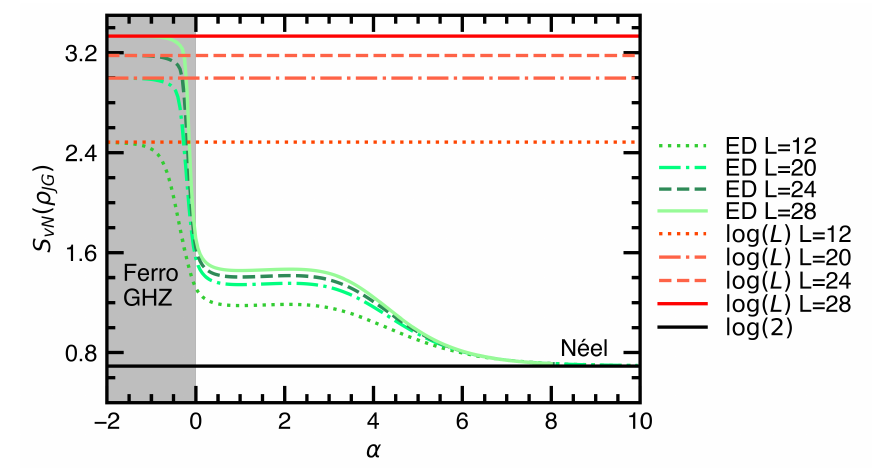
( ρ ) at different values of α for Figure 2: We plot the entanglement entropy S JG vN L = 12,20,24,28. Here ρ is the half-system reduced density matrix of the JG state. JG The results in green line are obtained through ED using symmetry restrictions. The red lines are the ferromagnetic GHZ predictions for the corresponding system sizes, while the black one is the Néel / anti-Néel cat state entanglement